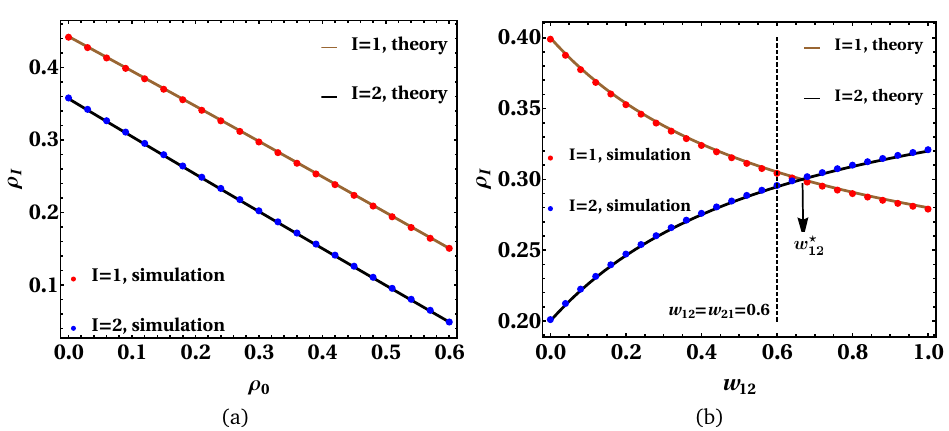
Figure 3: The figures (a) and (b) show the variations of the average species den- sities ρ ( I = 1,2) against vacancy density ρ I the steady state. The species densities decrease linearly with increasing ρ